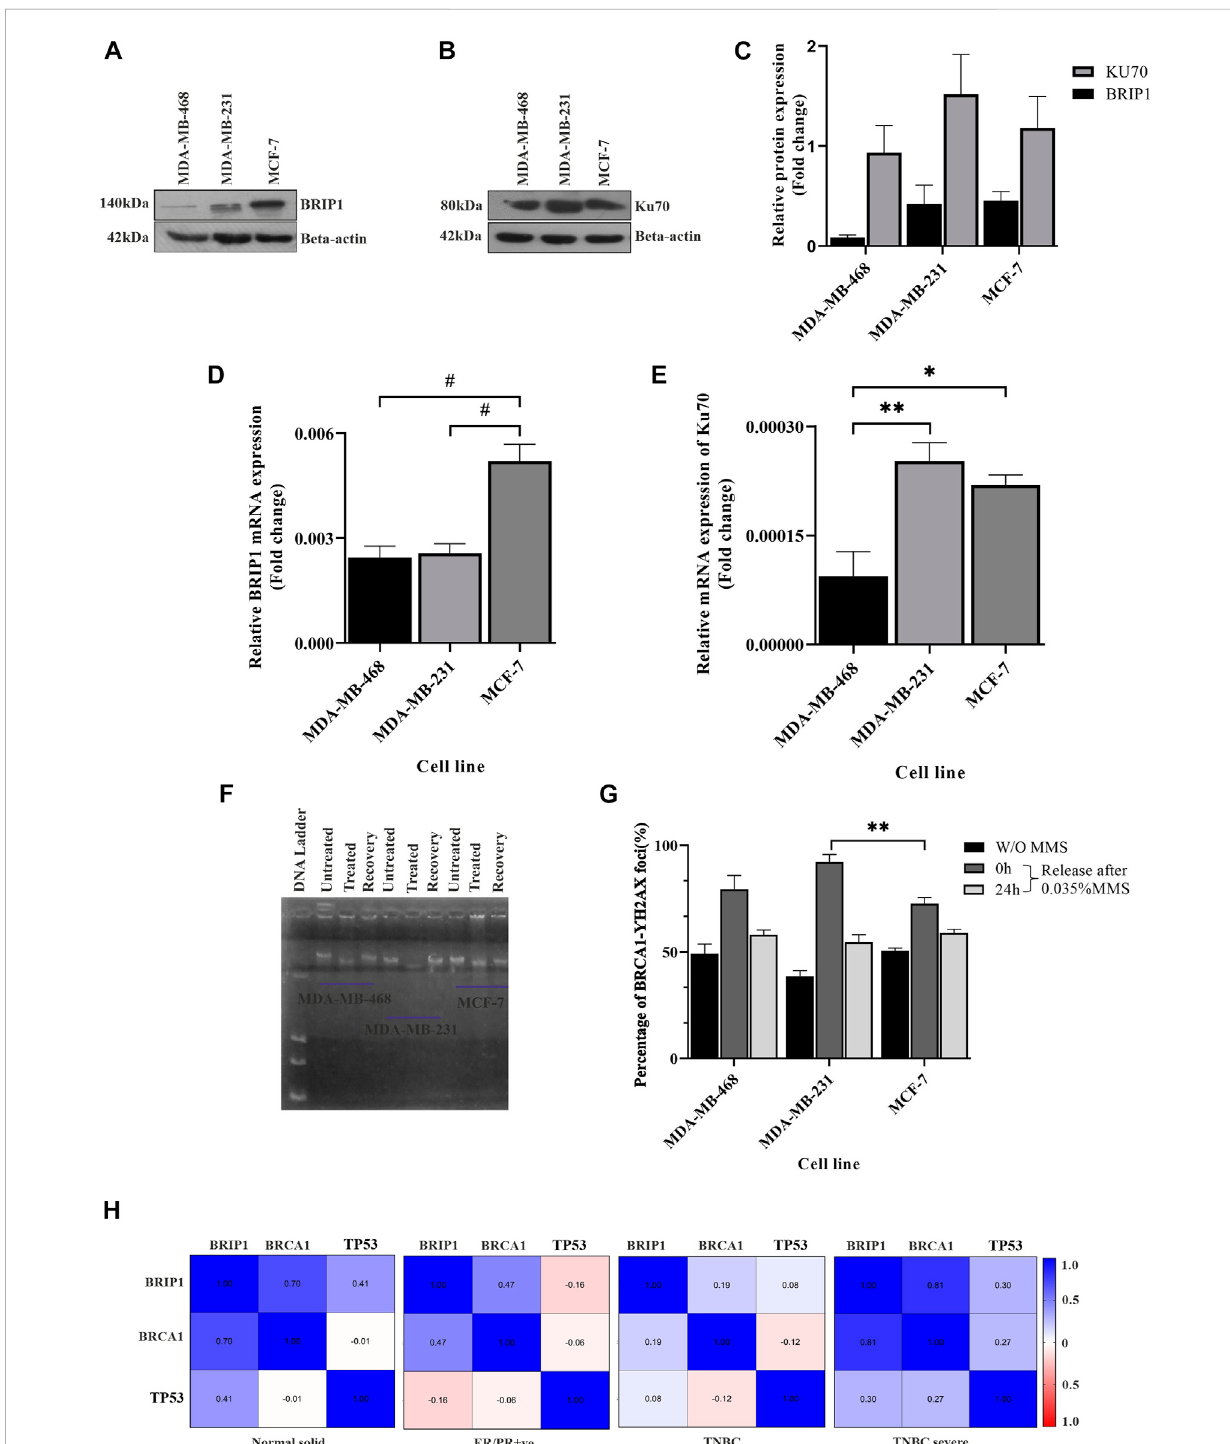
FIGURE 4 Upregulation of the repair pathway due to accumulated damage: (A,B) Overexpressed HR and NHEJ proteins in MDA-MB-231 cells. HR marker BRIP1 and NHEJ marker KU70 were detected by western blot analysis of proteins extracted from breast cancer lines, TNBC subtypes MDA-MB-468 and MDA-MB-231 and luminal type cell line MCF-7, using corresponding antibodies. β -Actin is given as the loading control. (C) Quanti fi cation of repair proteins in all the cell types. The intensity of the BRIP1 and KU70 bands from the western blot analysis was quanti fi ed using ImageJ software. The values of band intensities were normalized with corresponding intensities of β -actin. (D) The transcript level of BRIP1 is similar in TNBC cells: expression studies were performed with c DNA (500 ng of RNA) from the aforementioned lines. The bar graph represents the similar expression of BRIP1 in both the TNBC lines which were quanti fi ed by real-time qPCR from the technical triplicates and represented in the bar graph. (E) KU70 is overexpressed in MDA- MB-231 cells compared to other TNBC lines. The functional analysis of KU70 was performed with the extracted RNA from the aforementioned cell lines. The bar graph represents the expression of KU70 signi fi cantly more in the case of MDA-MB-231. The analysis was performed with technical triplicates. ΔΔ CtvaluewascalculatedfromtheCtvalueofGAPDH,thehousekeepinggene,andnotemplatecontrol(NTC),thenon-speci fi cbackground. (F)